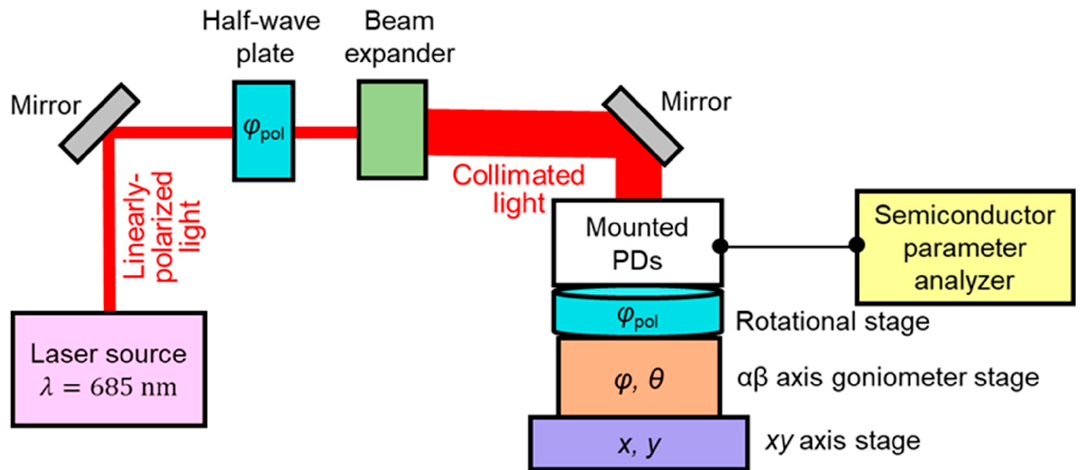
Figure 6. Measurement system for directivity of external QE in SOI PD with a SP antenna.